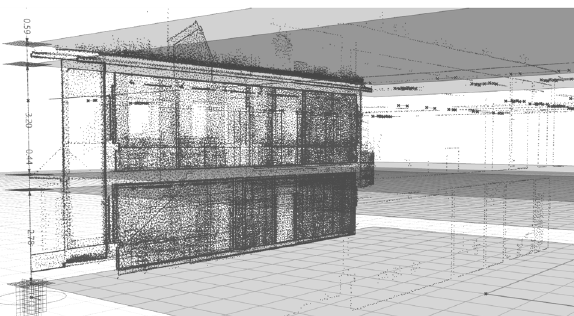
Figure 4 . The automatically defined main levels (floors and ceilings) of the scanned area of a two-storey building.